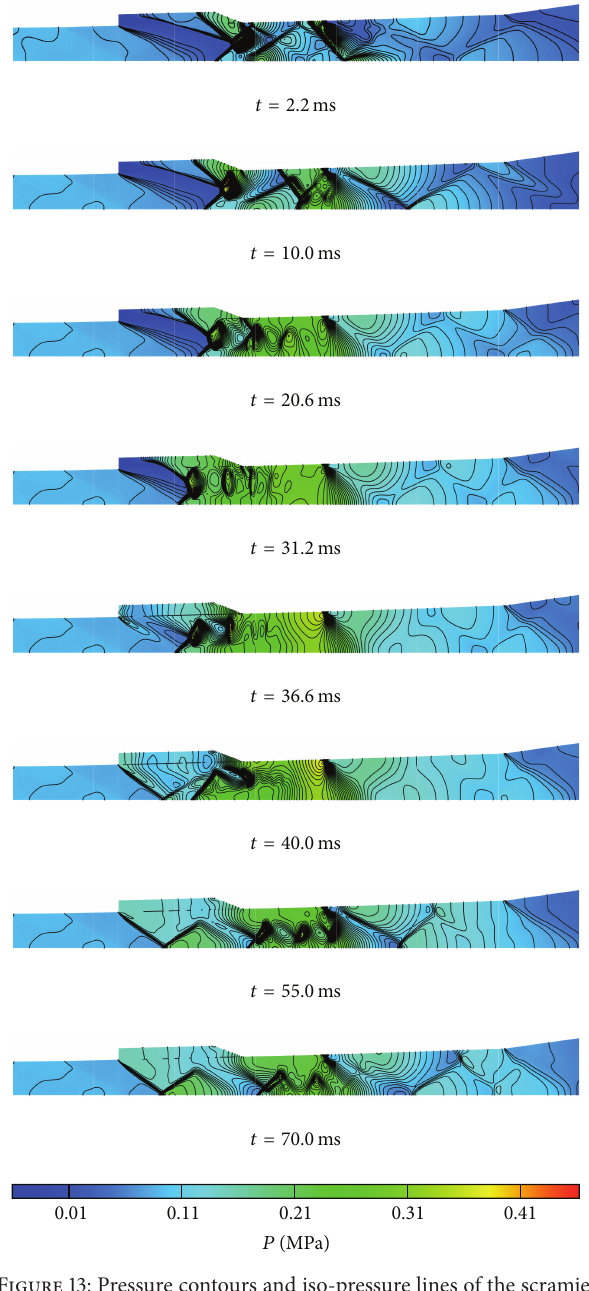
Figure 13: Pressure contours and iso-pressure lines of the scramjet combustor with air throttling at the location of 745 mm from the entrance of the combustor at different